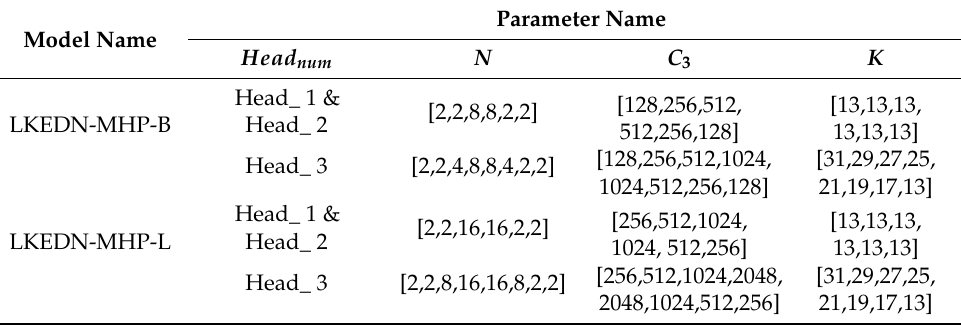
Table 1. The setting of architectural hyperparameters.